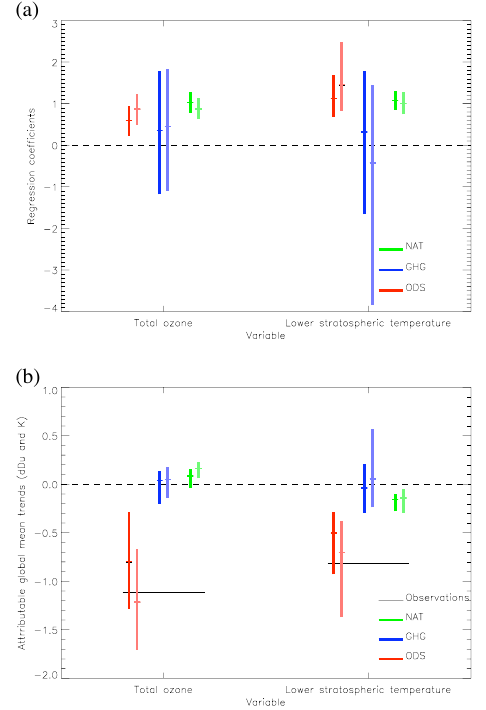
Fig. 3. (a) Regression coefficients of observed changes in to- tal column ozone (left) and lower stratospheric temperature (right) onto the simulated responses to ozone depleting substances (ODS), greenhouse gases (GHG) and natural forcings (NAT). Dark bars show results derived using the REF-B1, REF-B2 and SCN-B2b simulations, and light bars show results derived using the REF-B1, SCN-B2b and SCN-B2c simulations. Bars represent 5–95% uncer- tainty ranges. In both cases results are based on nine 3-yr means over nine 20 ◦ zonal bands, and use a representative EOF truncation of 40. Similar results were obtained using 2-yr means. (b) Trends in global mean total ozone (dDU/27 yr) and lower stratospheric temperature (K/27 yr) over the period 1979–2005 attributable to each forcing, derived from the attribution analysis (Allen and Stott, 2003). Horizontal black lines show the observed